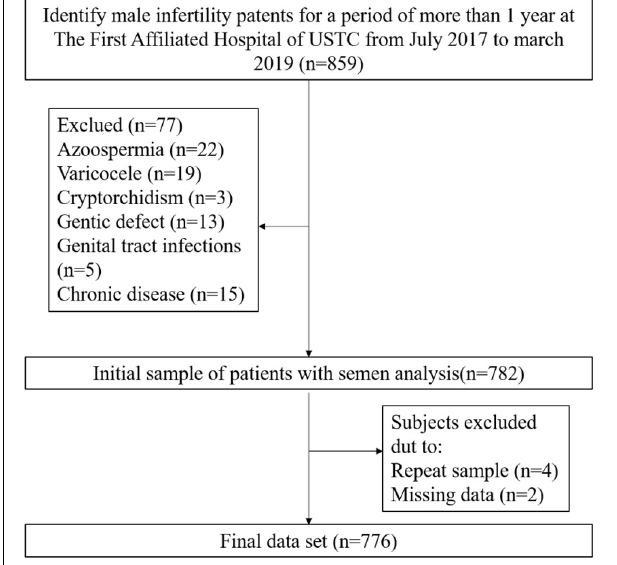
FIGURE 1 | Flow diagram for the selection of the eligible study